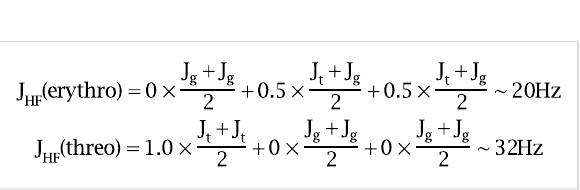
Figure 18: The observed 3 J HF coupling constants are an average over the rotational isomers.